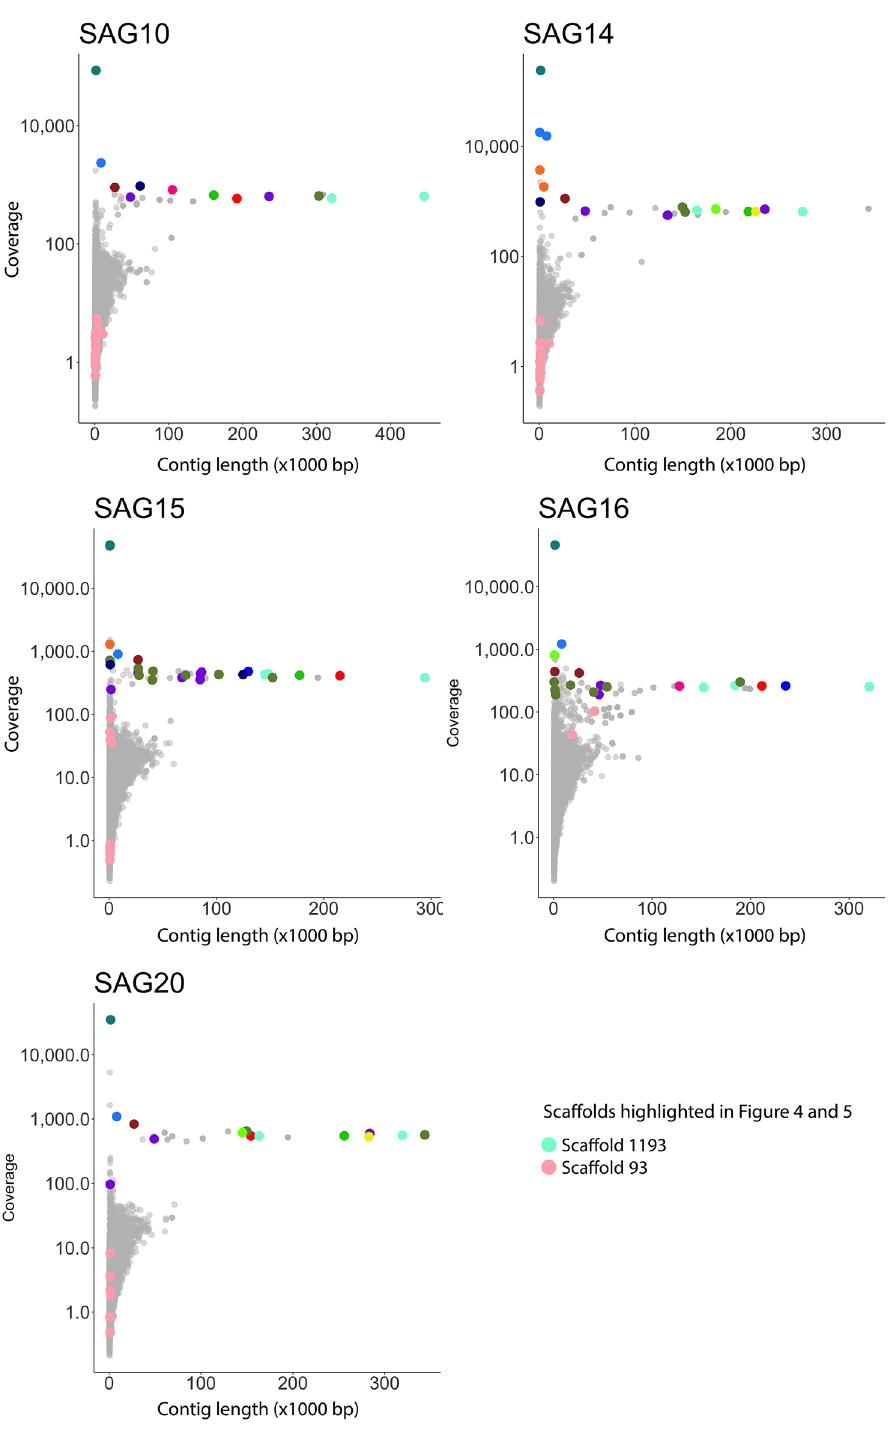
Figure 4. Coverage versus length of individual SAG assemblies. The k -mer coverage for each contig in the SAG assemblies as reported by the SPAdes assembler is shown on the y-axis and the length of the contig (in thousand bp) is shown on the x-axis. A selection of the longest contigs, and the contigs with the highest coverage (i.e. highly amplified genomic regions) are colored according to which genomic region they originate from (i.e. are assembled into the same scaffold in the meta-assembly). E.g. the contig with the highest coverage in all SAGs is from the same genomic region (dark blue color), and some of the longest contigs in almost all SAGs are from the same genomic region (aquamarine color; Scaffold 1193 in the figure legend). Scaffold 93 is also highlighted (pink color) as this portion of the genome is almost exclusively amplified in SAG16 and is in this sample assembled into two rather long contigs which make up scaffold 93 in the meta-assembly. This genomic region is therefore only represented by very small and low coverage contigs in the other SAGs. Plots created with the ggplot2 42 R